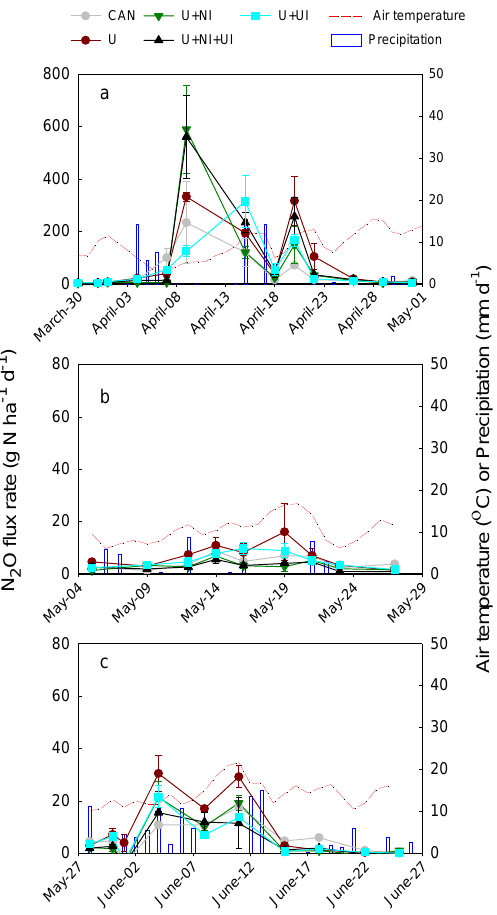
Figure 3. N 2 O flux rate (left vertical axis) and air temperature or precipitation (right vertical axis) for the fertilization treatments (CAN: calcium ammonium nitrate; U: urea; NI: nitrification inhibitor; and UI: urease inhibitor) after the 1st ( a ), 2nd ( b ), and 3rd ( c ) split N application in 2004. The vertical bars indicate the standard deviation of the mean (n = 2).